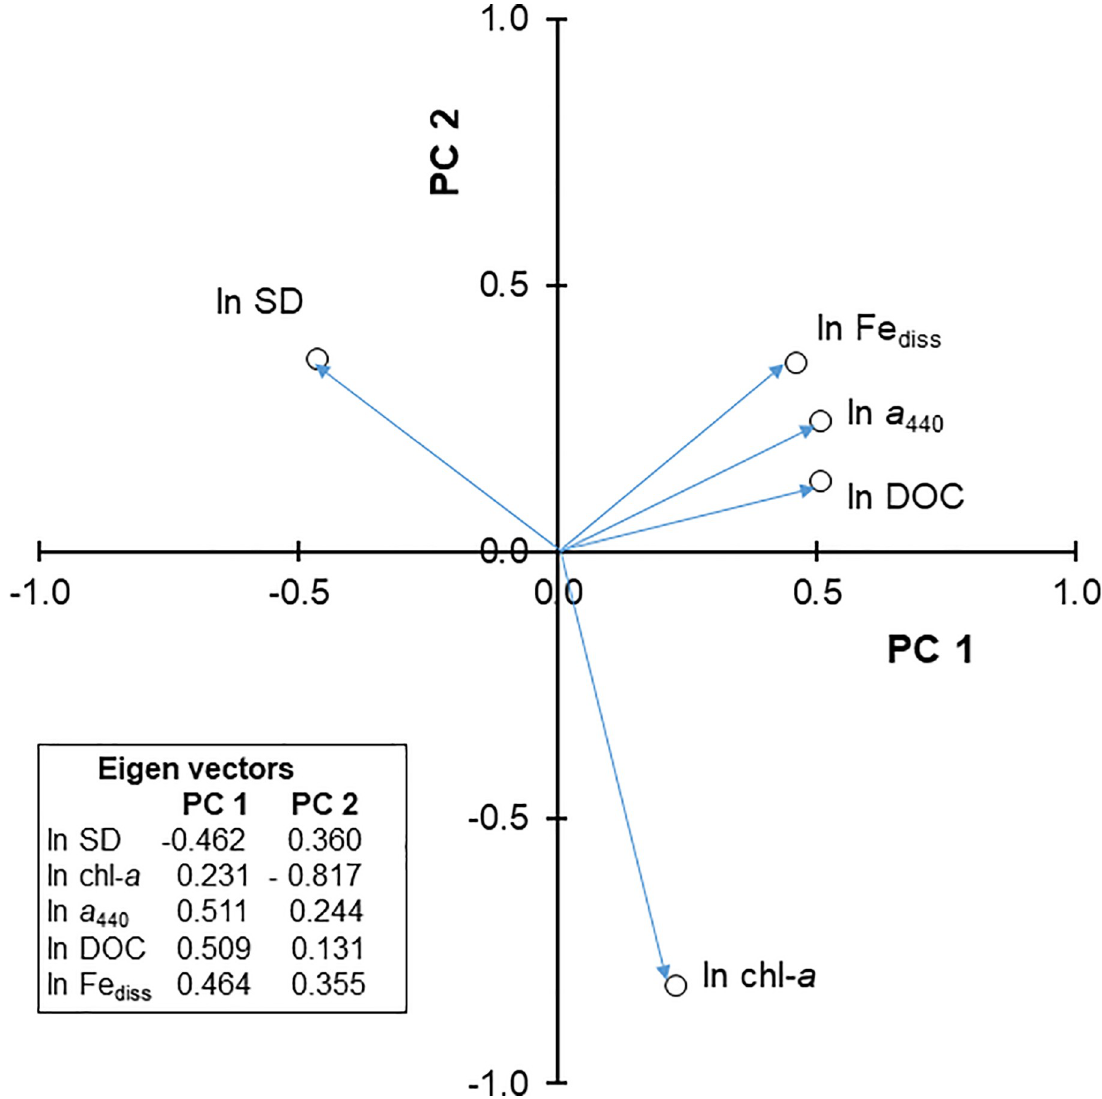
Fig 2. Plot of eigenvalues for the first two principal components of a principal components analysis of five variables ( a 440 , DOC, Fe diss , chl- a , and SD) for the whole data